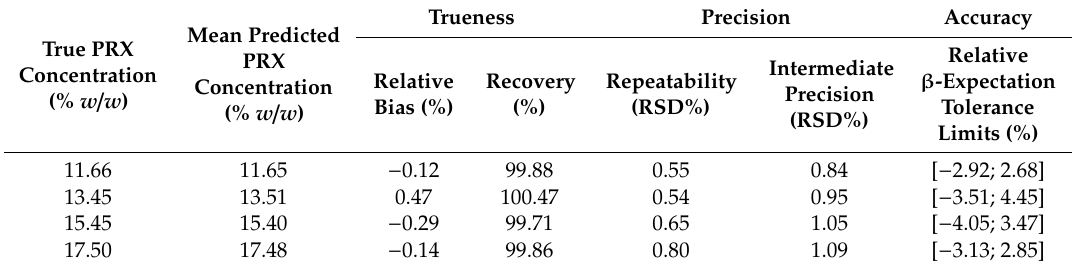
Table 4. Trueness, precision and accuracy results for each concentration level in the validation data sets.